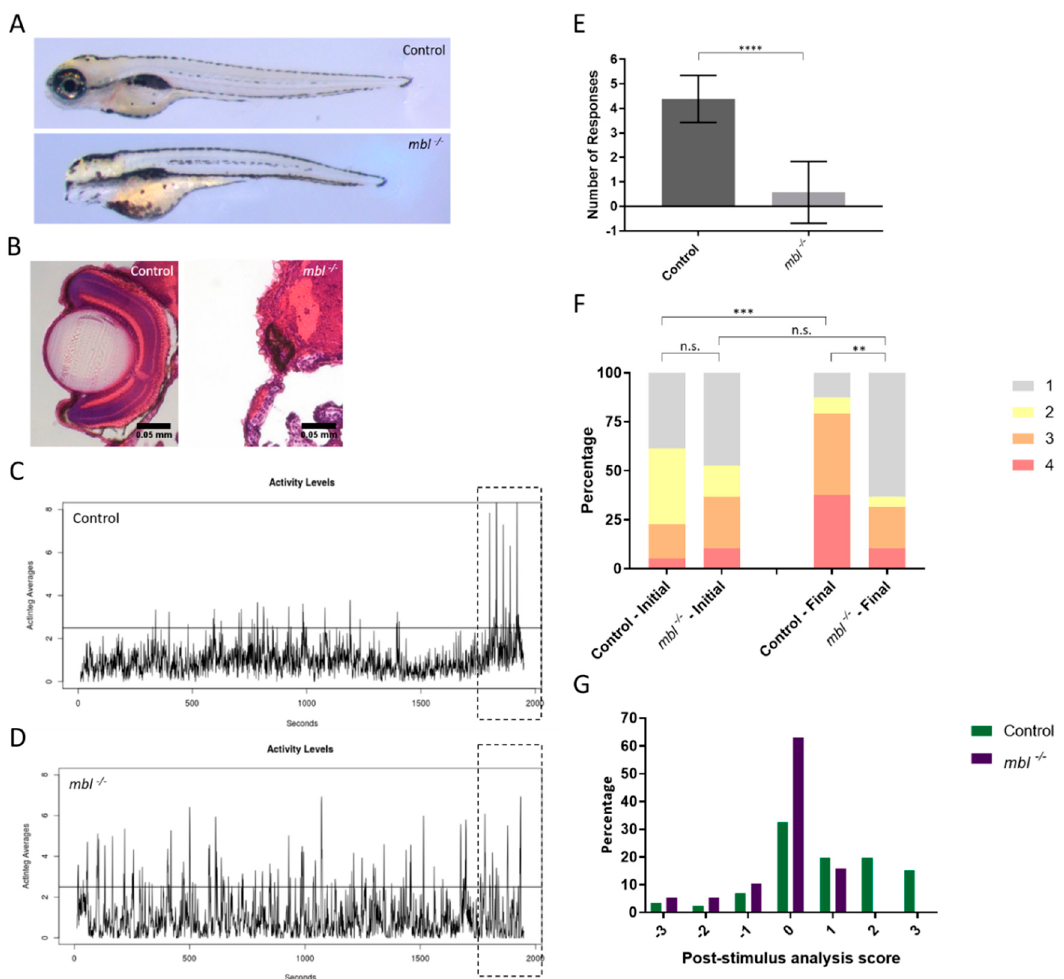
Figure 3. Utilizing the eyeless masterblind ( mbl ) mutant as a negative control for VIZN and OMR. ( A ) 6 days post-fertilization control (top) and mbl − / − mutants (bottom); ( B ) Hematoxylin and eosin staining larvae in (A). Control larvae display normal optic structures and retinal lamination while homozygous mbl − / − mutants lack eyes; ( C ) Activity profile of control and, ( D ) mbl − / − ; ( E ) VIZN analysis between control ( n = 39) and mbl − / − ( n = 28) (Mann–Whitney, p -value **** < 0.0001); ( F ) OMR analysis of larvae plotted as a bar graph which shows the shifts in the population between the initial and final positions (Bowker’s test of symmetry, p -value *** = 0.0004; Wilcoxon–Mann–Whitney, p -value ** = 0.0019); ( G ) the post-stimulus analysis which takes the difference between the final and initial position to show positional changes in individual fish. The same larvae were used for all assays. Scale bars in ( B ): 0.05 mm. n.s., not significant.